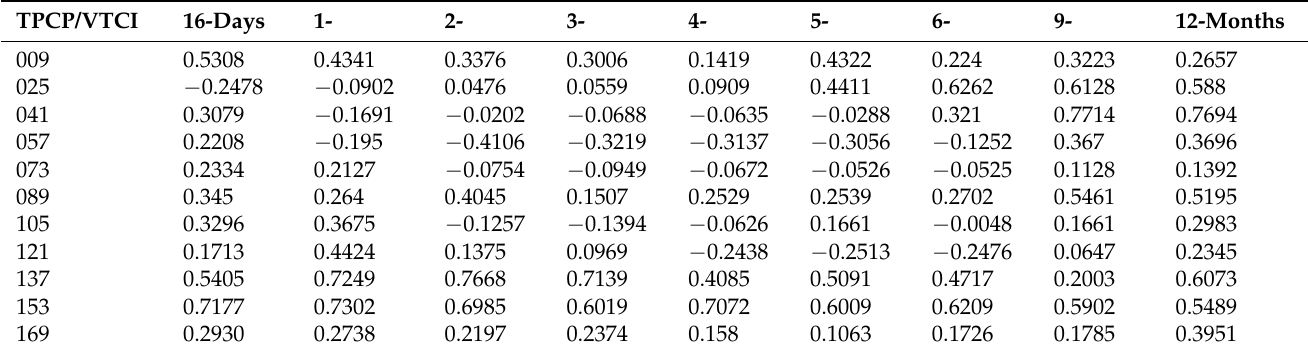
Table 3. The linear correlation coefficient between VTCI imagery values from D-009 to D-169 during 2011–2014 for the 16-day to the 12-month periods during